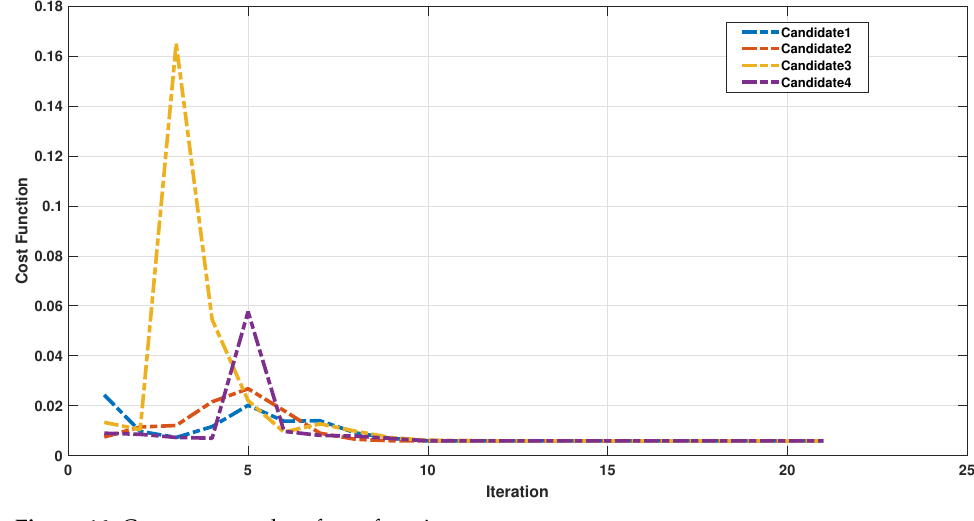
Figure 16. Convergence plot of cost function.